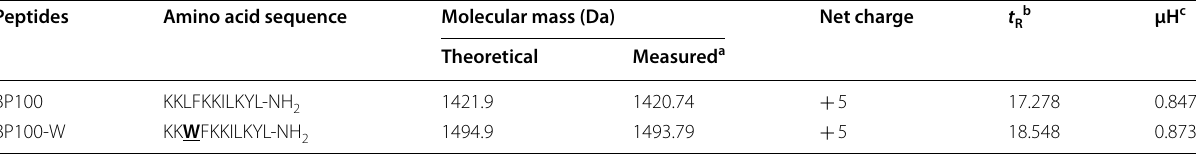
Substituted amino acids are shown in bold and underlined a Molecular mass was determined using matrix-assisted laser desorption/ionization (MALDI)-time-of-flight (TOF)-mass spectrometry (MS) b